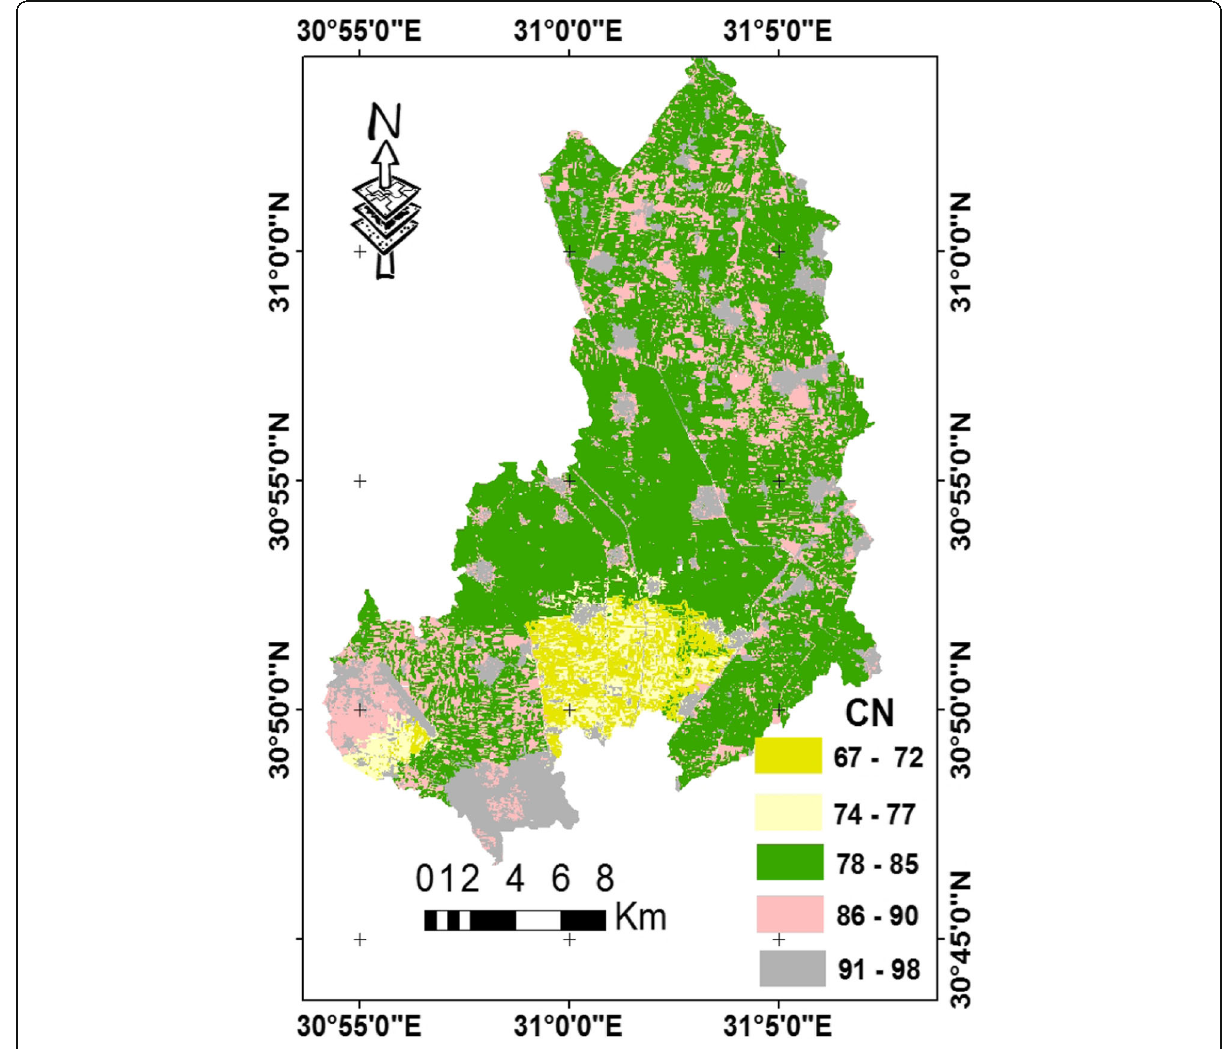
Fig. 5 Spatial distribution for the values of the curve